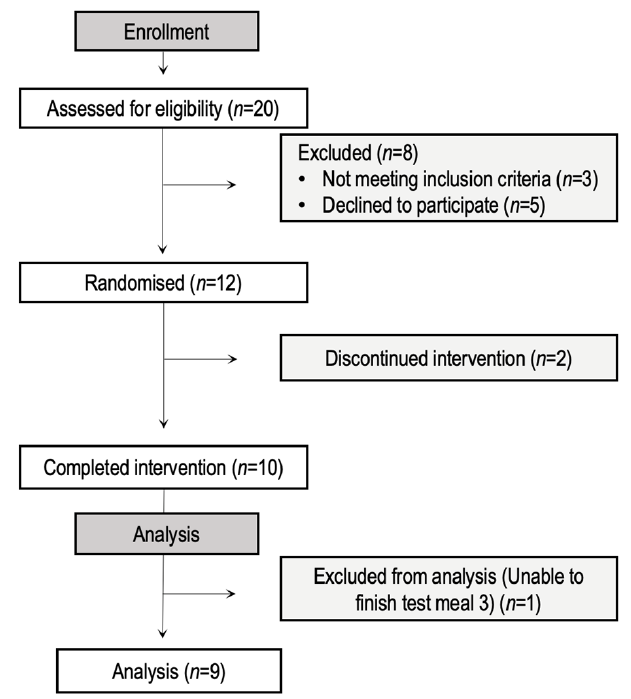
Figure 1. CONSORT diagram.